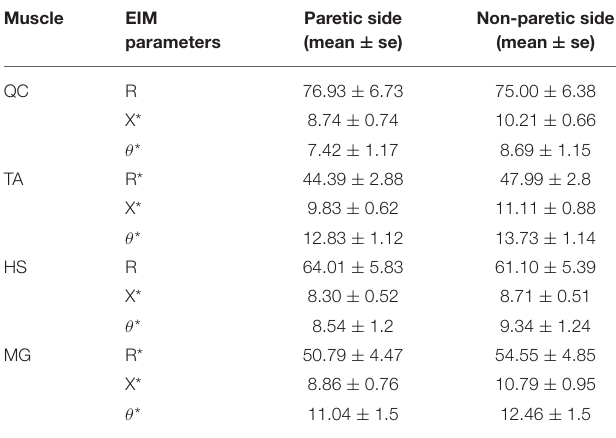
TABLE 2 | Comparison of EIM parameters before training. Muscle